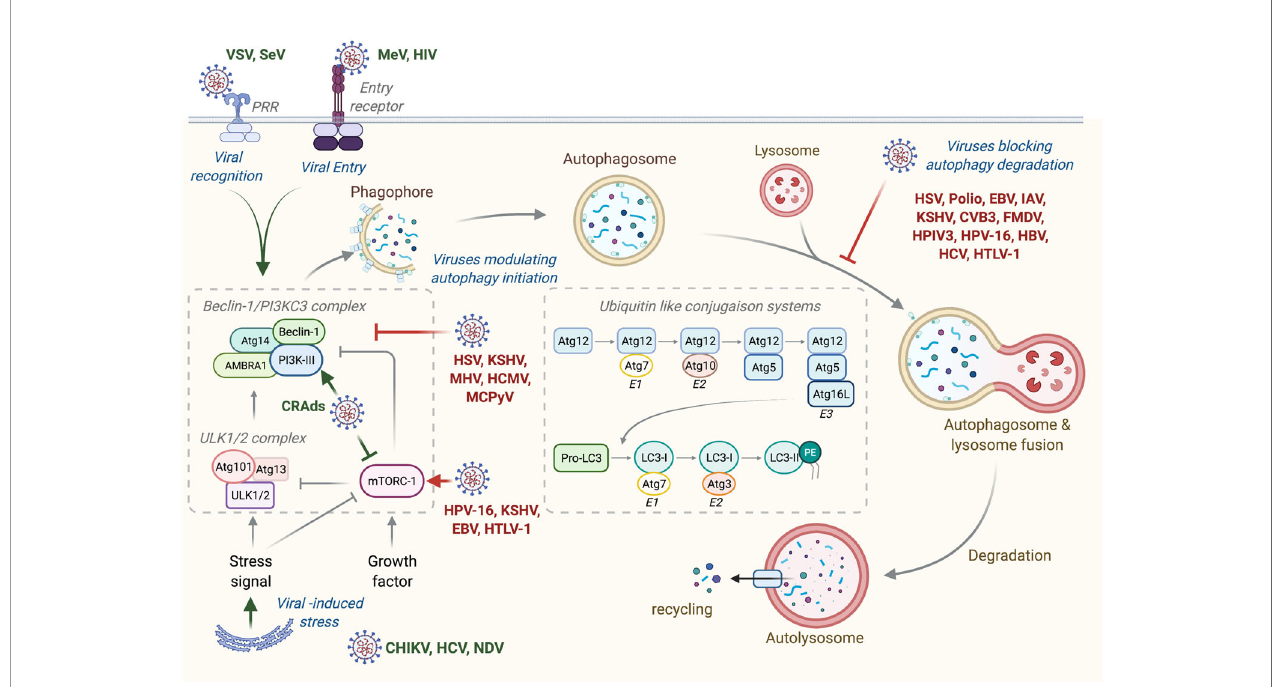
FIGURE 1 | Autophagy machinery and its modulation by viruses. Beclin-1/PI3KC3 complex activation, which is regulated by different mechanisms including the ULK1/2 complex and mTORC1 complex, results in the induction of an autophagic vesicle, which is characterized by a double-membrane, named autophagosome. Two ubiquitin-like systems are essential for autophagosome formation. In the fi rst, autophagy-related gene-12 (Atg12) is conjugated to Atg5, together forming a complex with Atg16L1, which decorates the outer membrane of the phagophore. Microtubule-associated protein 1 light chain-3 (LC3, also known as Atg8) constitutes the second ubiquitin-like system and conjugates phosphatidylethanolamine (PE) at the outer and inner autophagosomal membrane. Unlike the Atg12/ Atg5/Atg16L1 complex that is recycled by the protease Atg4, the LC3-PE (referred to LC3-II) remains associated with the inner membrane of autophagosome. The incorporation of phospholipid into the autophagosome membrane is essential for its elongation and regulates the membrane transport system. Autophagosome maturation is characterized by the formation of an autolysosome, the product of fusion with the lysosome. Viruses activate or inhibit autophagy at several step, as indicated on the fi gure. VSV, Vesical Stomatitis Virus; SeV, Sendai Virus; MeV, Measles Virus; HIV, Human Immunode fi ciency Virus; CRads, Conditionally Replicating Adenoviruses; HSV, Herpes Simplex Virus; KSHV, Kaposi ’ s Sarcoma-associated Herpesviru s ; MHV, Mouse Hepatitis Virus; HCMV, Human Cytomegalovirus; MCPyV, Merkel Cell Polyomavirus; HPV-16, Human Papillomavirus 16; EBV, Epstein-Barr Virus; HTLV-1, Human T cell Leukemia/lymphoma Virus type 1; CHIKV, Chikungunya Virus; HCV, Hepatitis C Virus; NDV, Newcastle Disease Virus; Polio, Poliovirus; IAV, In fl uenza A Virus; CVB3, Coxsackievirus B3; FMDV, Foot and Mouth Disease Virus; HPIV3, Human Parain fl uenza Virus 3; HBV, Hepatitis B